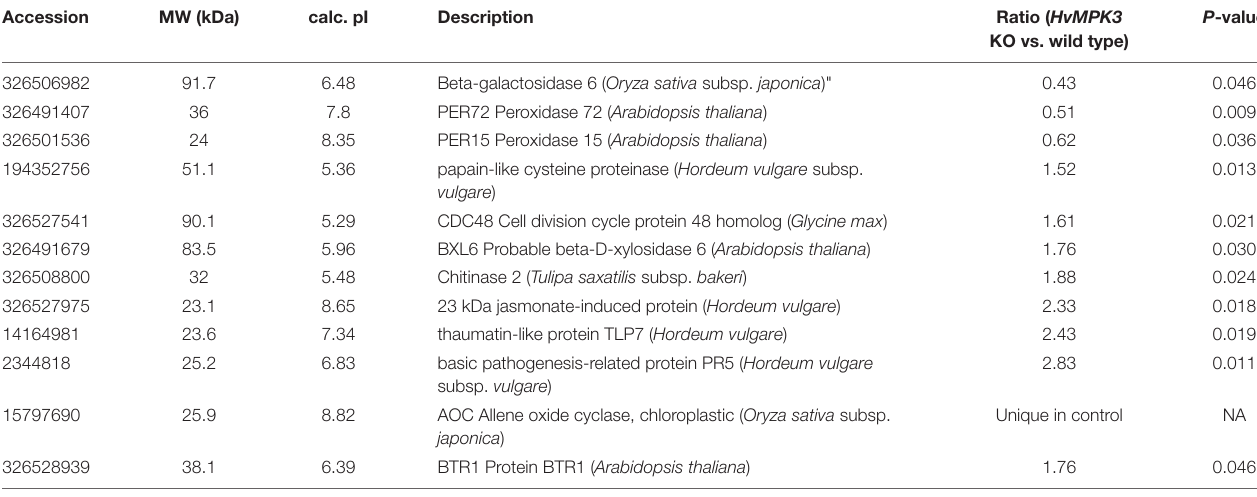
TABLE 2 | Differentially abundant defense related proteins found in flg22-treated barley wild type roots.